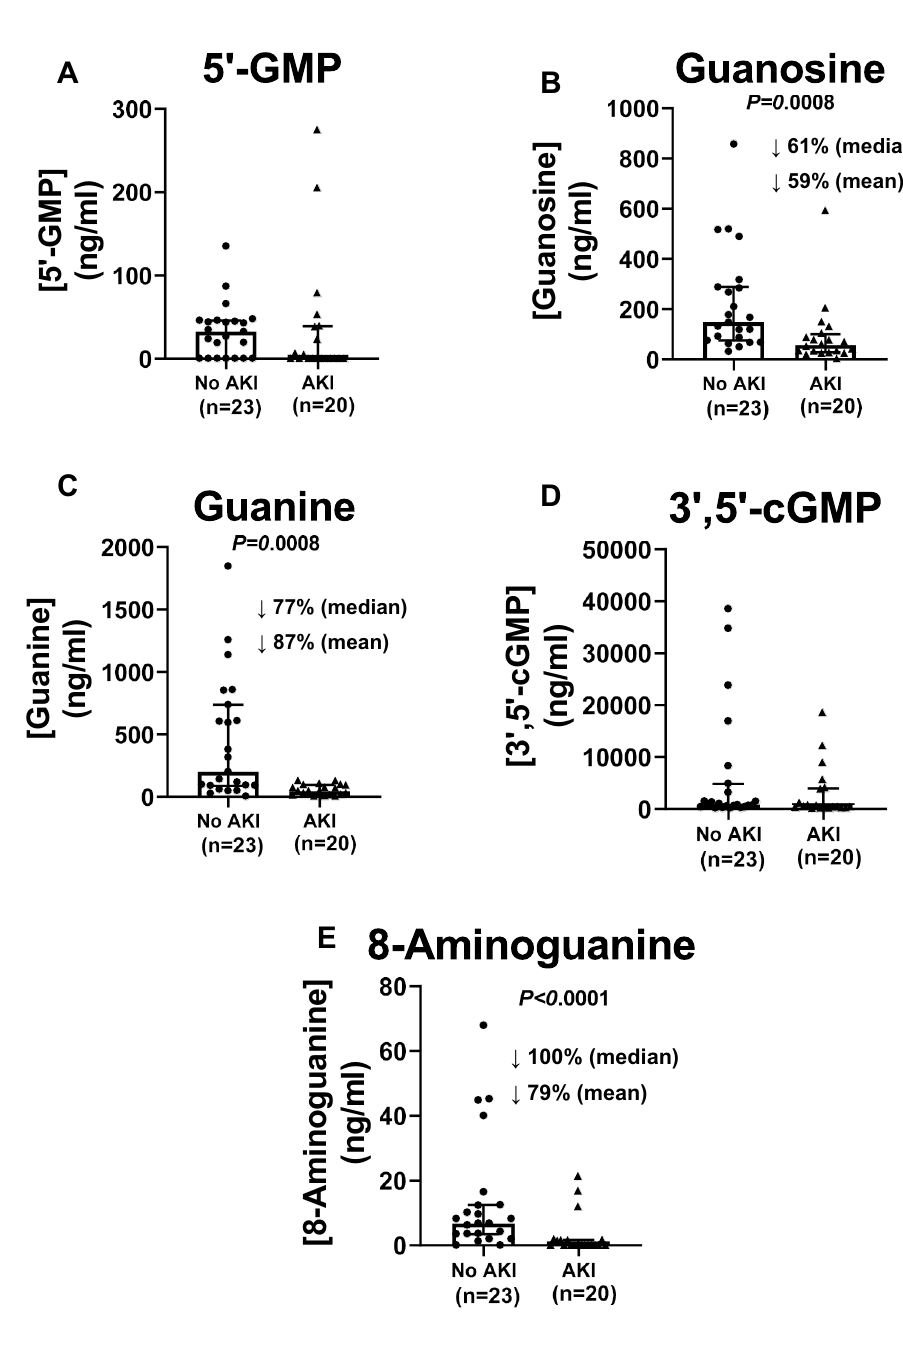
Figure 2. Effects of acute kidney injury (AKI) on urine levels (ng/ml) of ( A ) 5’-GMP, ( B ) guanosine, ( C ) guanine, ( D ) 3’,5’-cGMP and ( E ) 8-aminoguanine. Dot plots show individual values. Also shown are medians with interquartile ranges and the percentage decreases ( ↓ %) in both the median and mean values in AKI compared to patients without AKI (No